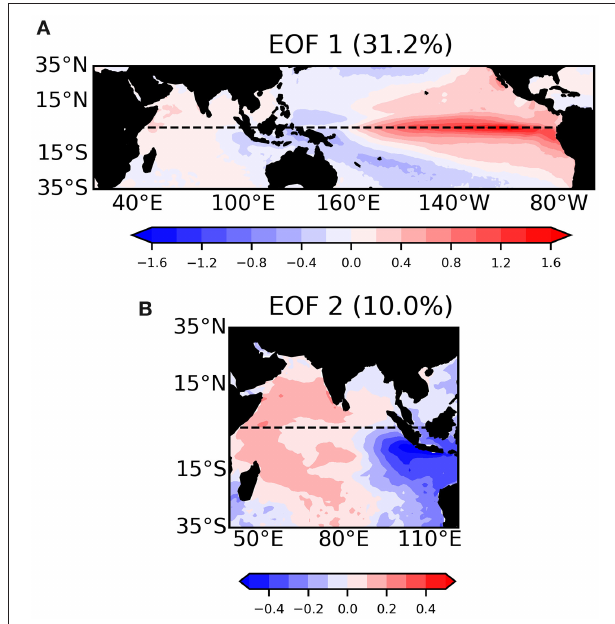
FIGURE 1 | (A) First EOF mode of the tropical Indo-Pacific SST monthly anomalies, showing the observed ENSO pattern. (B) Second EOF mode of tropical Indian Ocean SST monthly anomalies highlighting the IOD patterns. The monthly data cover the period 1980–2018 and are obtained from SODA 3.4.2 reanalysis. Percentages of variance explained by the EOF patterns are included. The black dash line depicts the